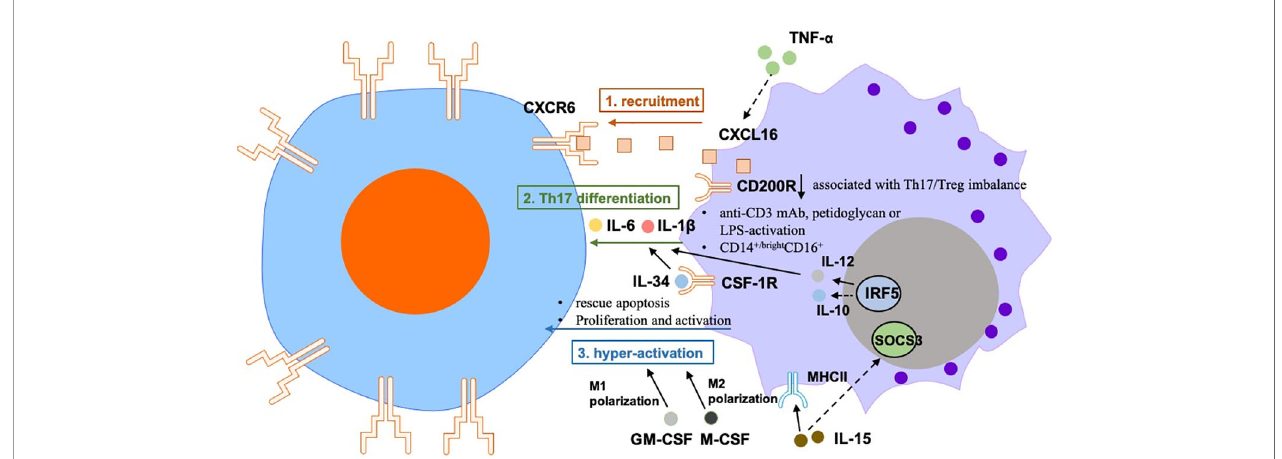
FIGURE 1 | The regulation of T cells by macrophages in RA is mainly re fl ected on the 1) recruitment: Macrophages-secreted CXCL16 induces migration of CXCR6 + T cells in RA joint synovium, which is regulated by TNF- a . 2) Th17 differentiation: abnormal expression of CD200R1 was associated with Th17/Treg imbalance in patients with active RA. Treatment with anti-CD3 mAb, peptidoglycan, or LPS-activated monocytes from peripheral blood can induce IL-17 secretion from CD4 + T cells. Treatment with anti-CD3/CD28-activated CD4 + T cells can boost Th17 polarization of PBMCs that were treated with RA synovial fl uid from healthy donors, which may be due to the up-regulation of IL-6 and IL-1 b from monocytes. Human CD14 +/bright CD16 + monocytes promoted Th17 differentiation of memory CD4 + T cells. Activation of the IL-34-CSF-1R pathway in synovial macrophages can promote Th17 differentiation of T cells. IRF5 promotes monocytes/macrophages- induced Th17 differentiation of T cells. 3) induction of hyper-activation of T cells by monocytes/macrophages: IL-15 lead to increased expression of MHCII and reduced expression of the SOCS3 in macrophages, which activate the proliferation of autoreactive CD4 + T cells in RA. Monocytes rescue synovial T cells from glucocorticoid-induced apoptosis. LPS + IFN g -treated M-CSF-dependent macrophages inhibit the proliferation, activation and cytokine production of CD4 + T